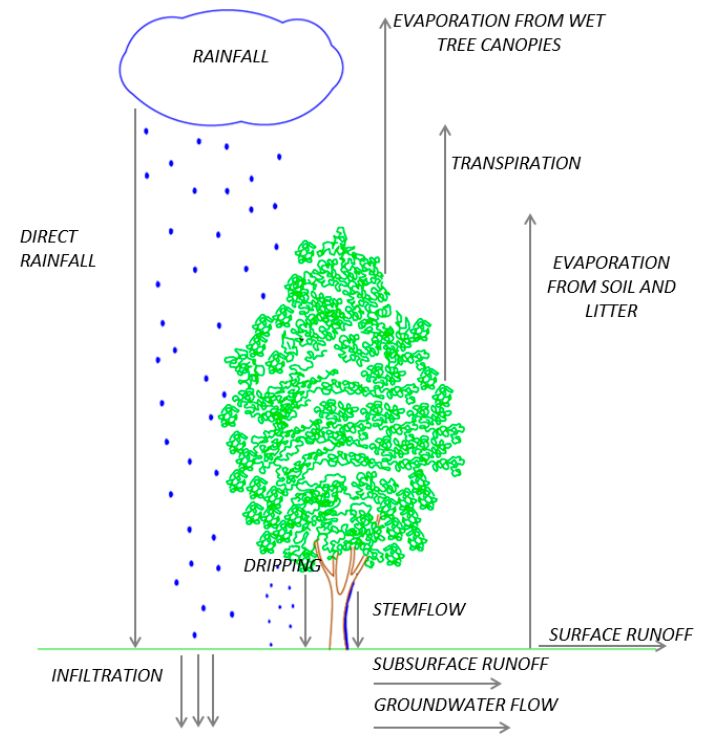
Figure 1. Hydrological cycle of rainfall